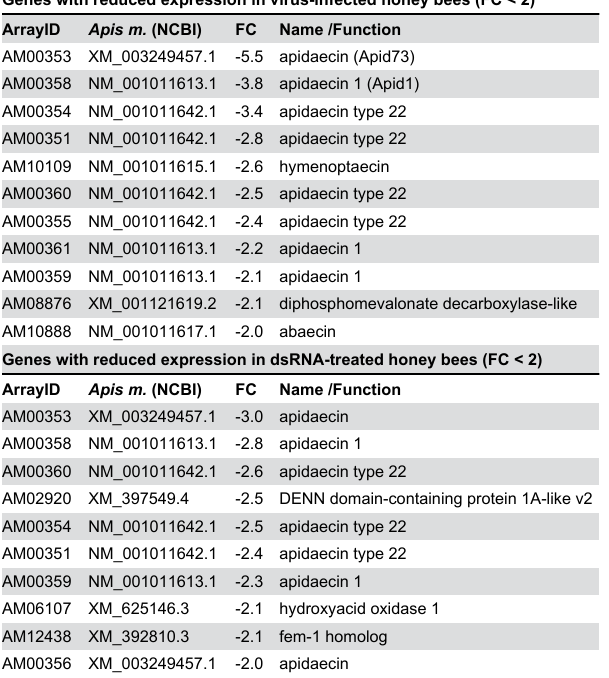
Table abbreviations are as follows: microarray feature identification number = Array ID; honey bee NCBI reference number = Apis m. (NCBI); fold-change = FC; and